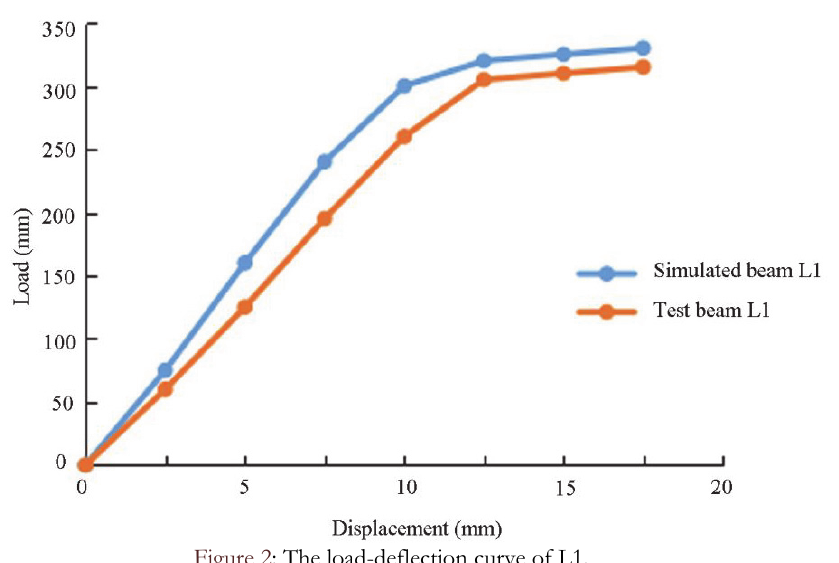
Figure 2: The load-deflection curve of